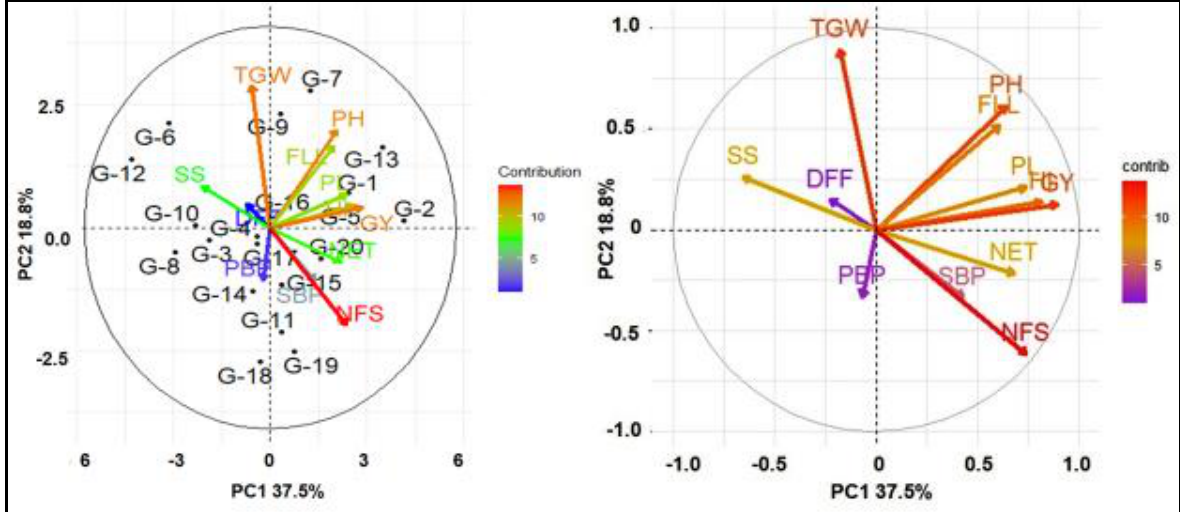
Figure 2. Biplot based on PCA shows the relationship of secondary traits with grain yield. DFF — days to 50% flowering; PH — plant height; NET — number of effective tillers per hill; FLL — flag leaf length; PL — panicle length; PBP — number of primary branches per panicle; SBP — number of secondary branches per panicle; NFS — number of filled spikelets per panicle; SS — spikelet sterility; TGW — 1000-grain weight; HI — harvest index; GY — grain yield.